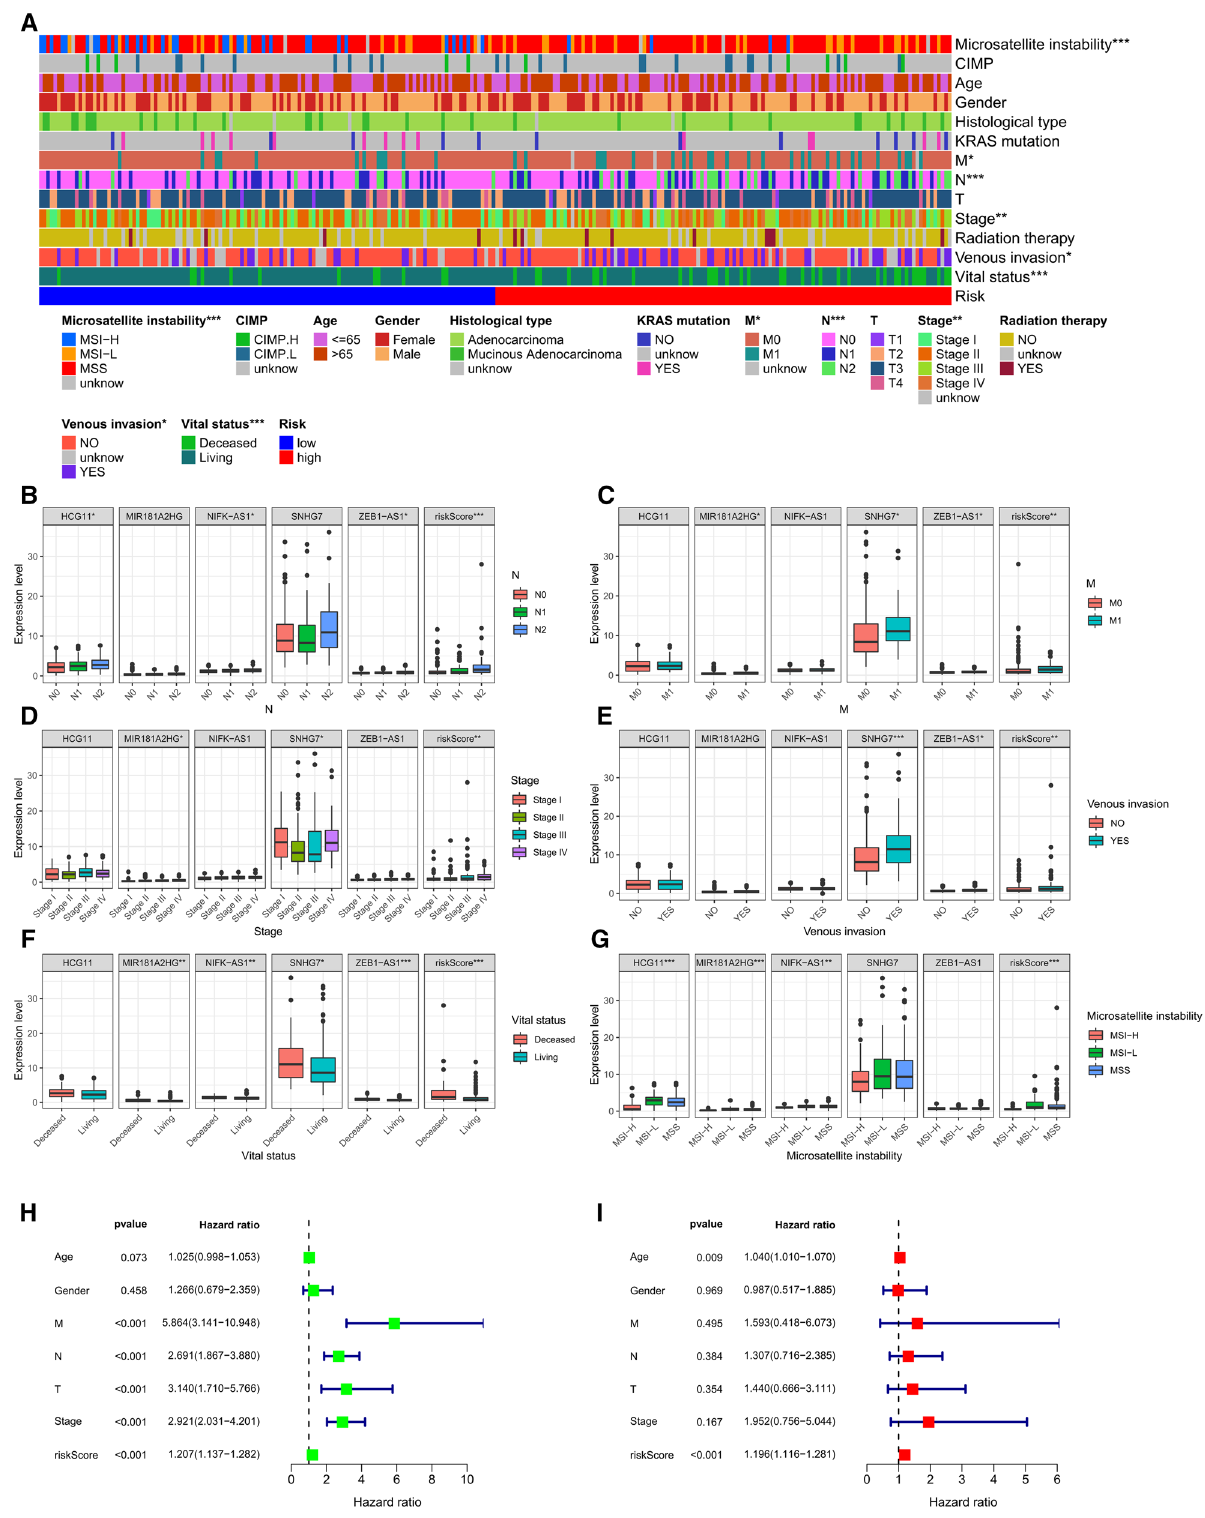
Figure 4. The correlation between the risk signature and clinical parameters. ( A ) The band diagram and box plots showed that ( B ) N classification, ( C ) M classification, ( D ) AJCC tumor stage, ( E ) Venous invasion, ( F ) Vital status, and ( G ) Microsatellite instability were significantly associated with the risk score. ( H ) Univariate Cox regression analysis revealed that AJCC tumor stage, T classification, N classification, M classification and risk score were statistically different. ( I ) Multivariate Cox regression analysis demonstrated that only age and risk score were independent prognostic predictors. * P < 0.05; ** P < 0.01; *** P <